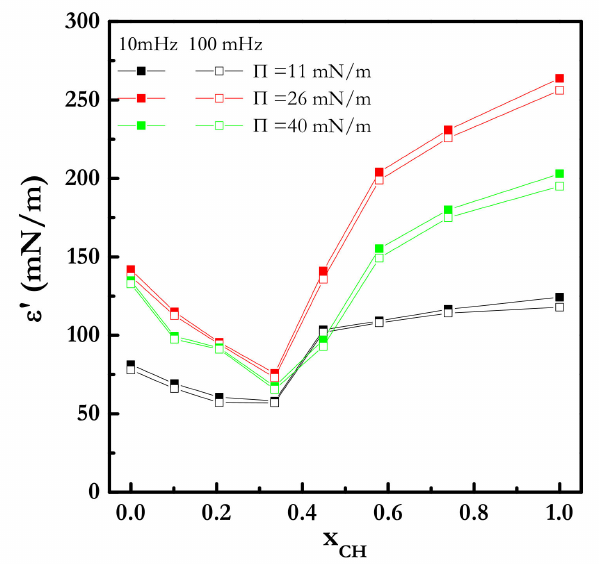
Figure 11. Dependences of the elastic modulus component on x CH for binary mixtures of CH and CS spread at the water/vapor interface at different surface pressures at 35 ◦